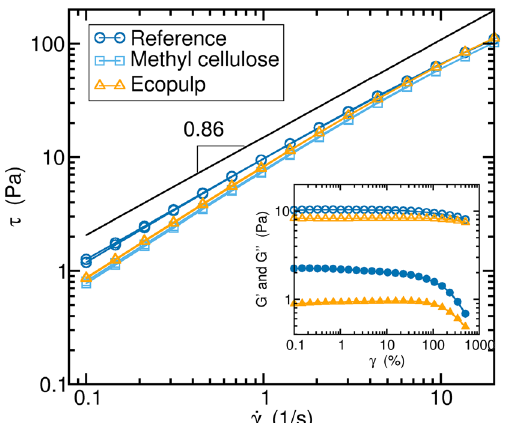
Figure 5. Rheological properties of the suspensions. Flow curve of a pure MC solution, with squares showing typical shear thinning behavior, where the shear stress τ is plotted against the strain rate Ecopulp fibers (triangles) increases the viscosity by a constant, but does not affect the shear thinning behavior. On the other hand, the long reference fibers (circles) slightly increase the shear thinning, as seen in change of slope of the curve and hence in the shear thinning exponent. The inset shows the storage G ′ (filled symbols) and loss G ′′ (unfilled symbols) modulus of the reference and Ecopulp fibers over the shear amplitude γ